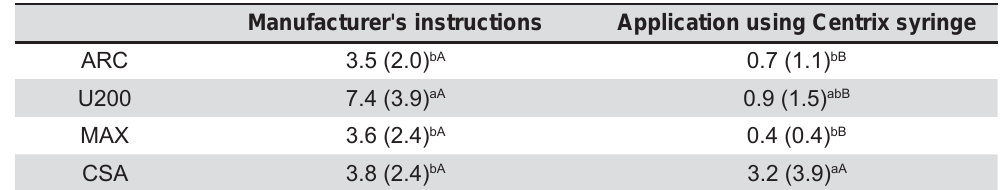
Table 1- Percentage of voids/gaps per cement according to application technique